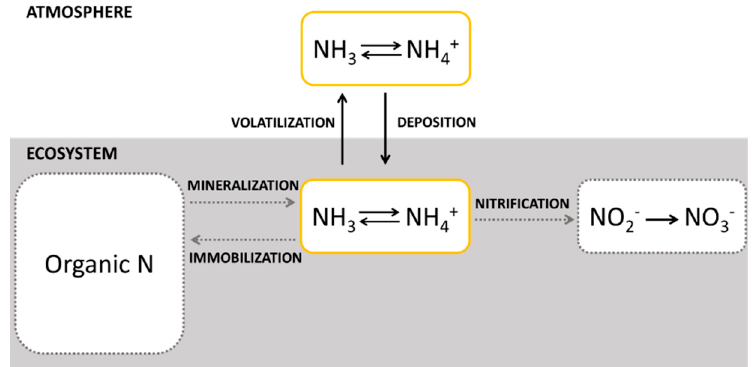
Scheme 1. Simplified scheme of NH x exchange between an ecosystem, composed of soil and vegetation, and the atmosphere. The solid orange boxes highlight the NH x measured in this study, with the grey dashed boxes showing processes and pools that were not measured.